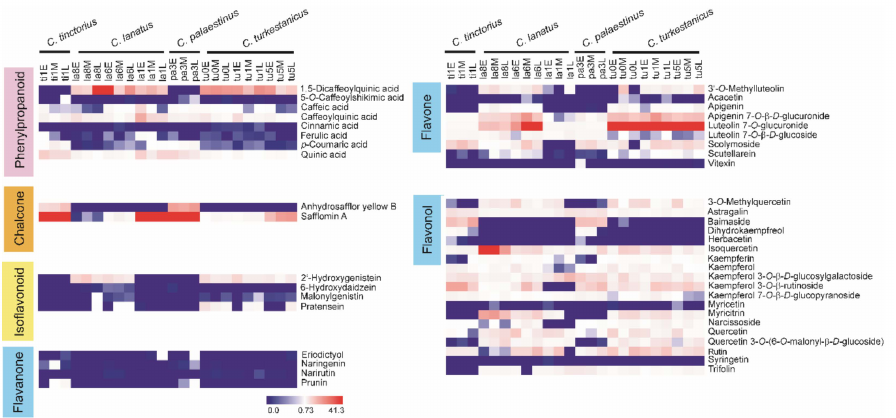
Figure 2. Heat maps comparing the levels of phenylpropanoids, chalcones, and flavonoids in sa ffl ower wild species. Relative peak areas were normalized to construct a comparative heat map. The abscissa at top displays the names of the samples, and the ordinate at right displays the names of the metabolites. The deeper the red color, the higher the peak area of the metabolites; the deeper the blue color, the lower the peak area of the metabolites. Sample name abbreviations: the first two letters indicate the first two letters of the species name, the number indicates the last digit of the PI number, and the letters E, M, and L indicate early, middle, and late stages of development, respectively. For example, “ti1E” indicates the sample PI 592391 ( C . tinctorius ) at the early stage of